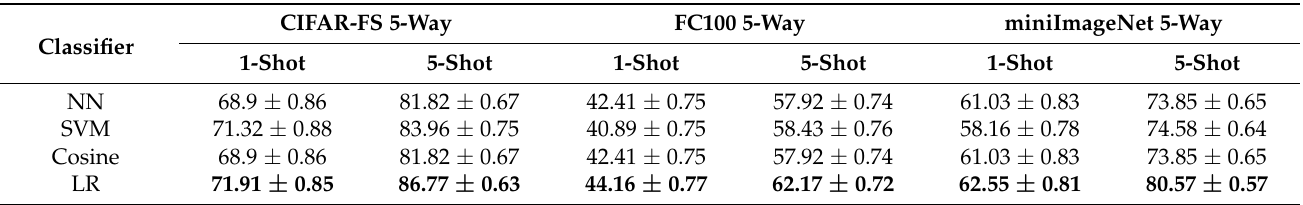
Table 6. Ablation experiments with classifiers. “NN” and “LR” denote nearest neighbor classifier and logistic regression. “Cosine” stands for cosine